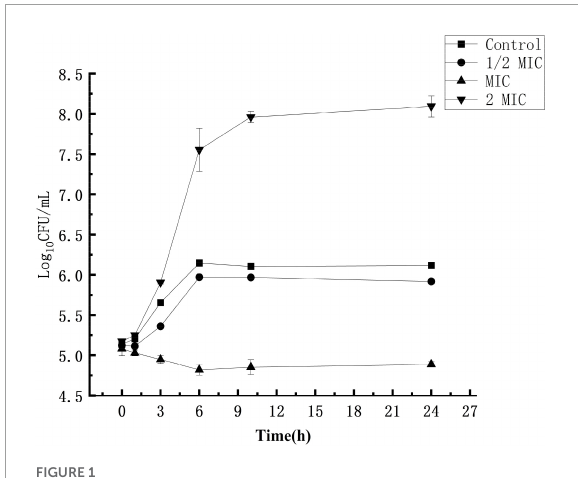
FIGURE1 Effect of anthocyanin on Staphylococcus aureus